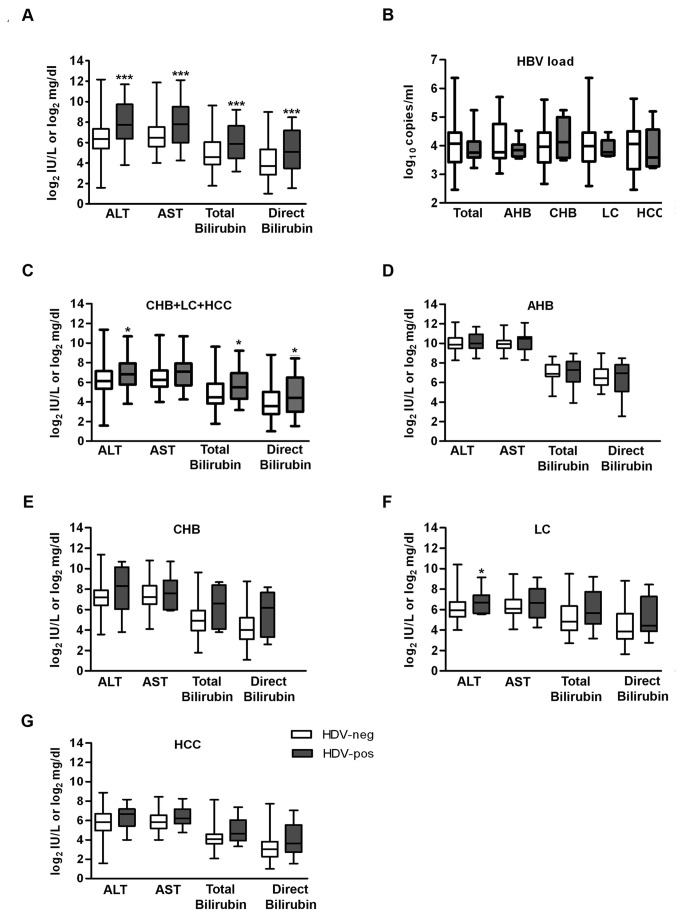
Subclinical characteristics in HBV/HDV coinfection.(A) Subclinical characteristics of the HBsAg-positive Vietnamese patients with (dark bars) and without HDV-coinfection (white bars). The serum transferase levels as well as concentration of total and direct bilirubin were significantly higher in HDV-positive patients than HDV-negative individuals (***denotes p<0.001). (B) Determination of HBV loads in the different study groups (AHB, CHB, LC, and HCC) and of all patients (total) revealed no statistically significant differences (p>0.05). (C to G) Subclinical characteristics of HDV-infection of the Vietnamese HBsAg-positive patients of (C) AHB, (D) total chronic cases (CHB+LC+HCC), (E) CHB, (F) LC, and (G) HCC groups. ALT was significantly higher in HDV-positive than in HDV-negative patients in LC group (F, * denotes p<0.05). AST was slightly higher in the CHB group in comparison to the HCC group (E,G, p<0.05). The values at the X-axis are given in log2 scale; ALT and AST = IU/l, bilirubin = mg/dl, and HBV loads = HBV-copies/ml. p<0.05 is statistically significant. White bars depict HDV-negative and dark bars HDV-positive samples of the Vietnamese HBsAg-positive patients.